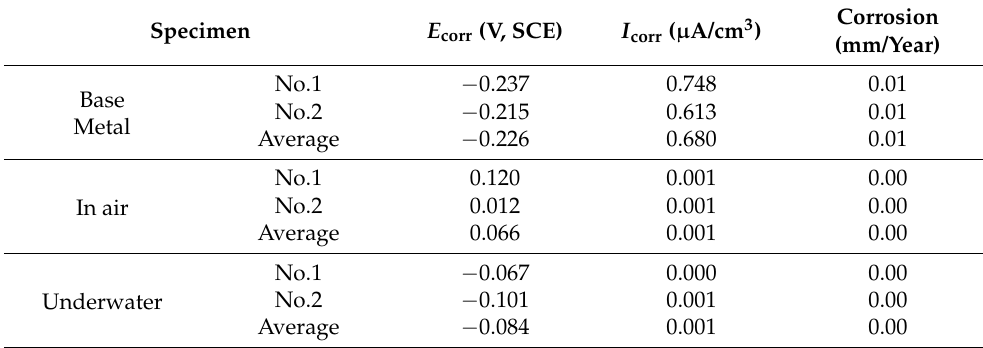
Figure 11. Potentiodynamic anodic polarization curves for ( a ) underwater laser weld, ( b ) in − air laser weld, and ( c ) base metal specimens. Table 3. Electrochemical data obtained from measured potentiodynamic anodic polarization curves of specimens in 3.5% NaCl solution at 25 °C.